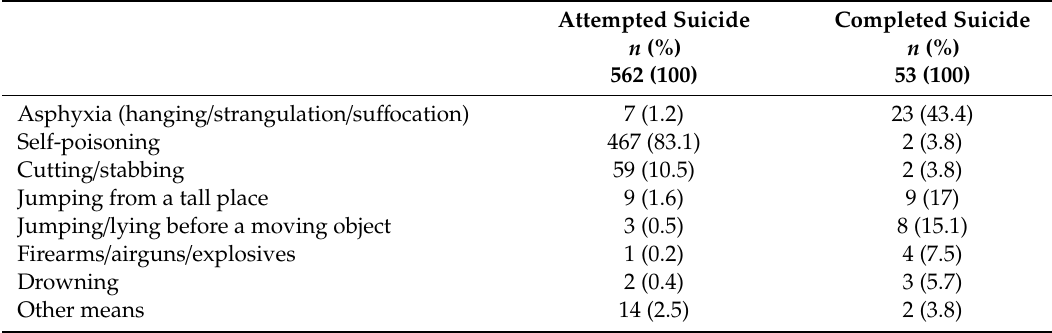
Table 1. Completed suicide and attempted suicide